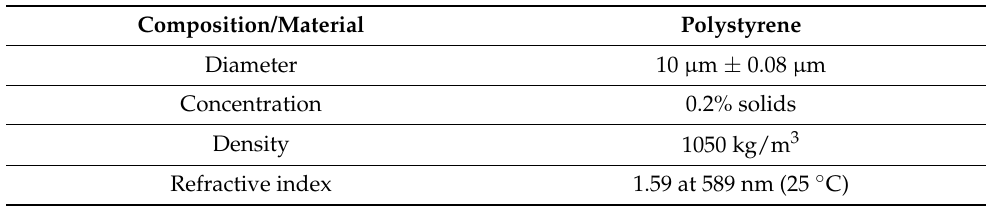
Table 2. Specification of seeding particle